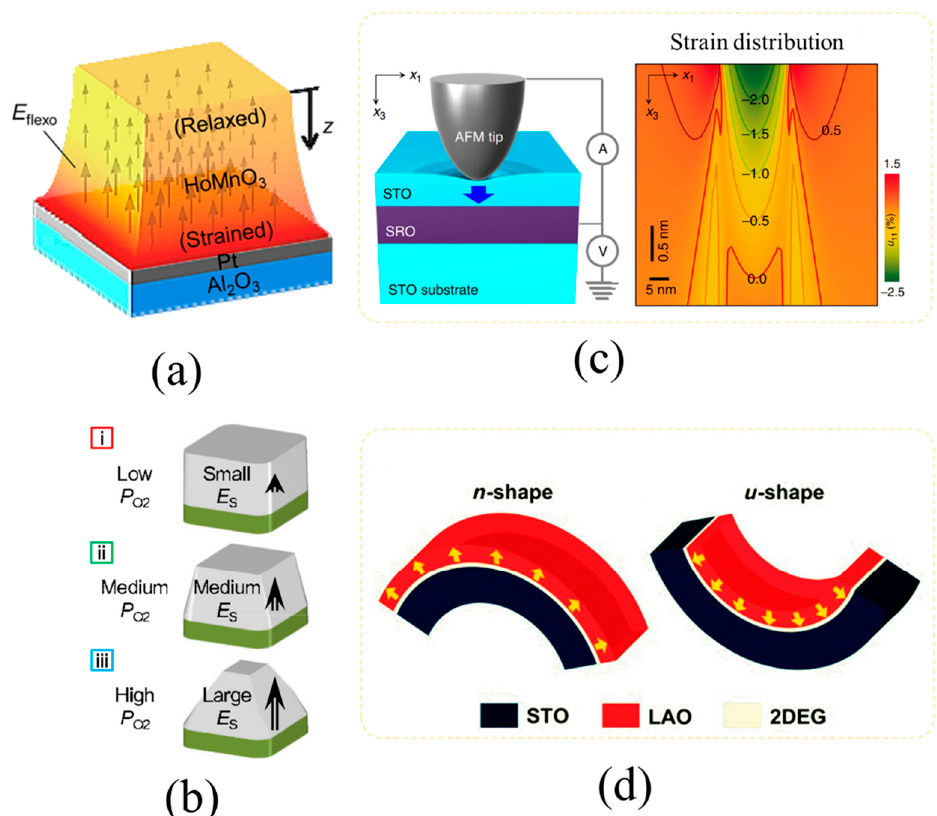
Figure 14. ( a ) The film generating a strain gradient through the interfacial lattice mismatch between the film and substrate Reprinted with permission from [93]. Copyright 2012 American Chemical Society. ( b ) Oxygen partial pressures controlling the oxygen vacancy gradient that modulates the strain gradient of the film. Reprinted with permission from [82]. Copyright 2011 American Physical Society. ( c ) The sharp probe of an atomic force microscope applying a compressive force to a film, causing strain gradient. Reprinted with permission from [85]. Copyright 2019 Springer Nature. ( d ) Bending films and substrates to obtain strain gradient. Reprinted with permission from [94]. Copyright 2019 American Physical Society.